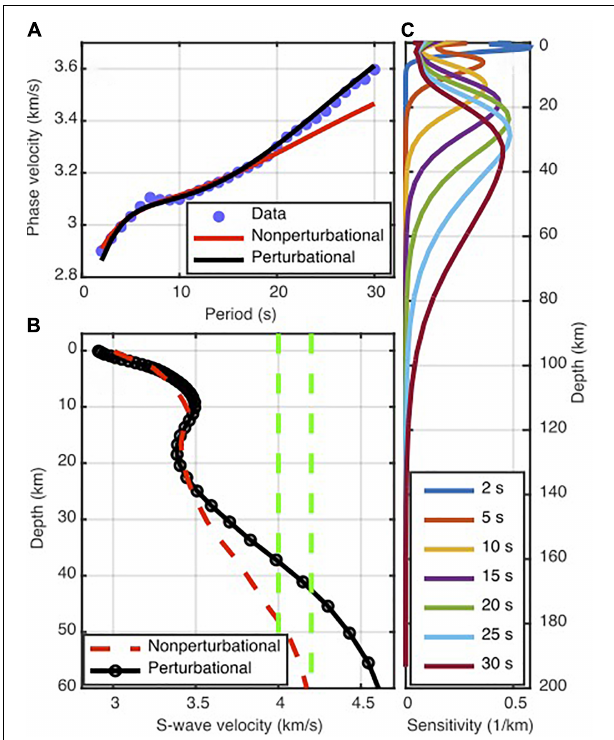
FIGURE 6 | (A) An example local dispersion curve and predicted curves from non-perturbational (initial model) and perturbational (final model) inversions. (B) Inverted S-wave velocity depth models using non-perturbational (initial model) and perturbational (final model) inversions. Black circles represent the optimal non-uniform finite-element grid of layers. S-wave velocities of 4.0 and 4.2 km/s as candidate velocities for detecting the Moho at depth are shown by vertical green dashed lines. (C) Sensitivity kernel of the final perturbational